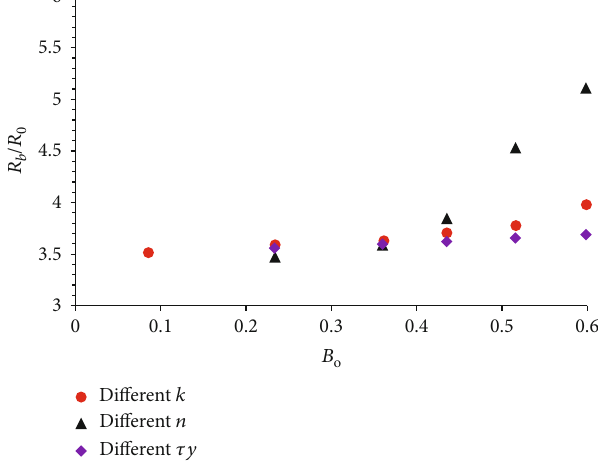
Figure 14: Variation of dimensionless equivalent radius of detached bubble with the B o